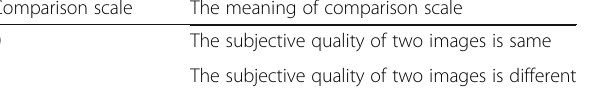
Table 4 Comparison scales for subjective quality evaluation Comparison